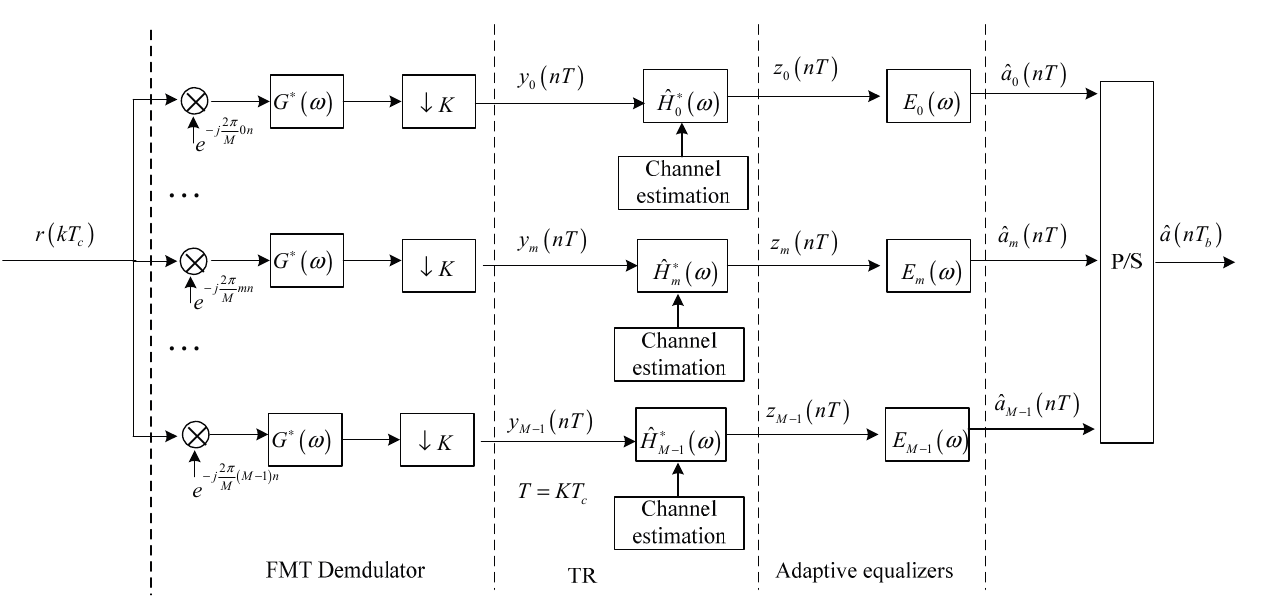
Figure 3. Block diagram for the receive structure of the proposed